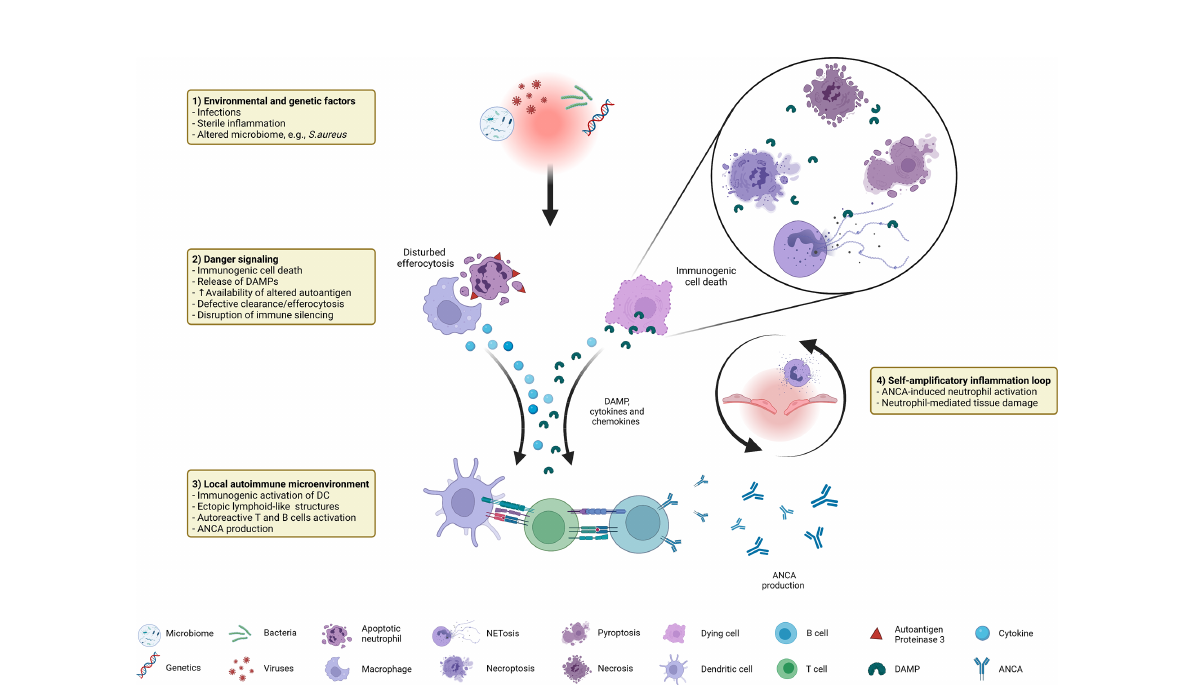
FIGURE 1 Immunogenic cell death in GPA at a glance: distinctive factors and mechanisms associated with immunogenic cell death contribute to autoimmune reactions in